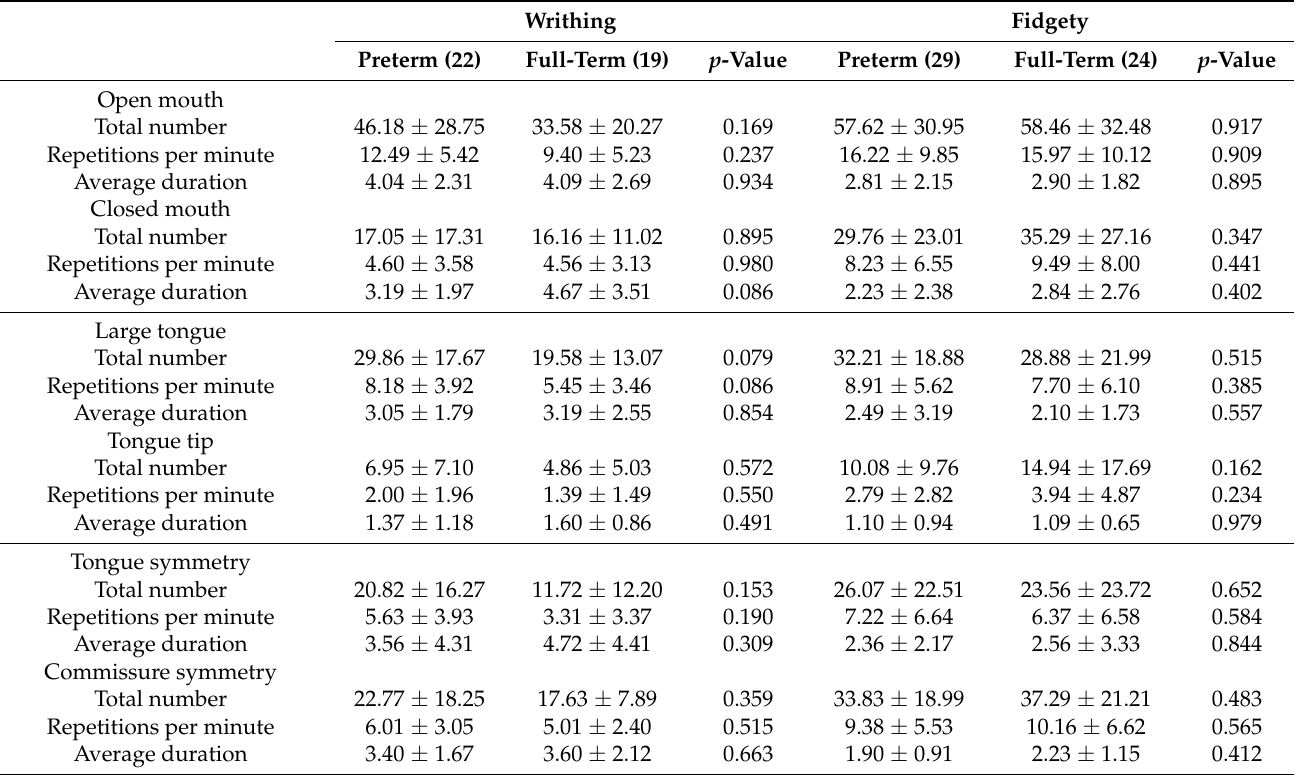
Table 5. Means and standard deviations of the total number, repetitions per minute, and average duration (milliseconds) of oral movements according to GMs stage and gestational age at